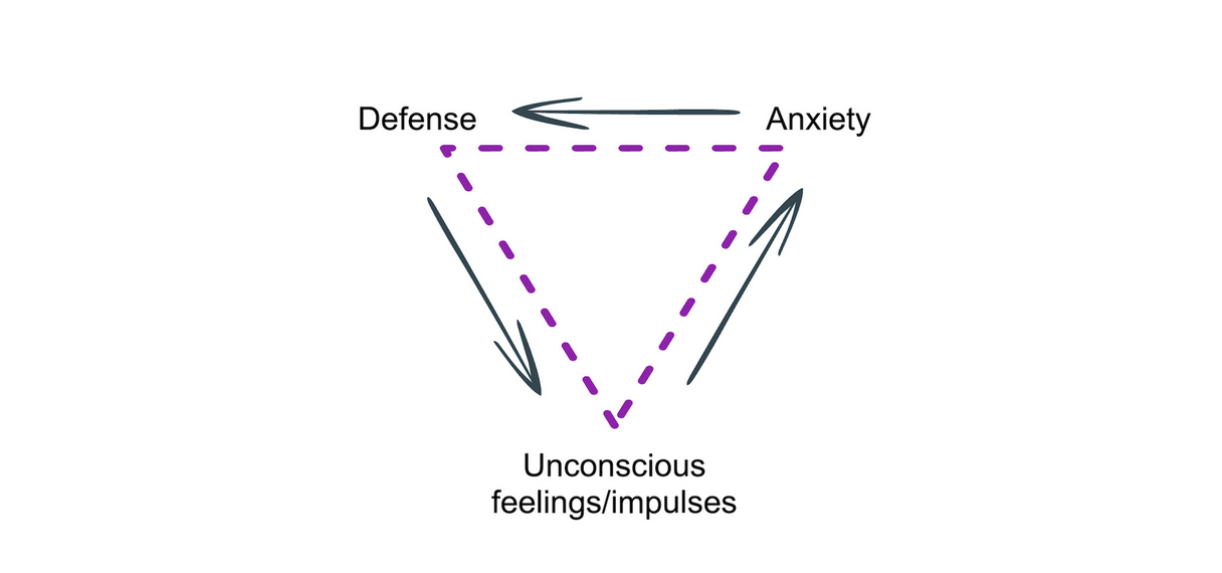
Figure 2. Malan's (1979) triangle of